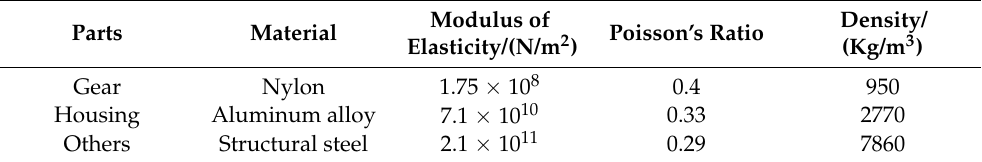
Table 2. Material Properties.